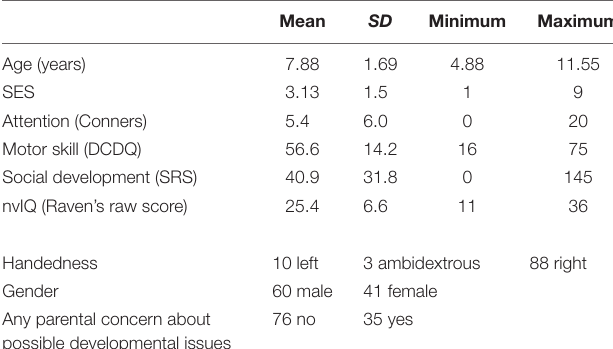
TABLE 1 | Characteristics of 101